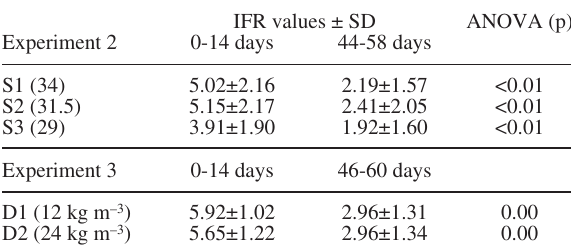
Fig . 3. – Weekly mean values of instantaneous specific feeding rate (IFR) and daily water temperature (T) during experimental periods 2 and 3. A, Experiment 2, effects of salinity: S1 (34), S2 (31.5) and S3 (29). B, Experiment 3, effects of culture density: D1 (12 kg m –3 ) and D2 (24 kg m –3 ). Table 3. – Mean values of instantaneous specific feeding rate (IFR) ± SD from the initial and final fortnight of experimental periods 2 (effects of salinity) and 3 (effects of culture